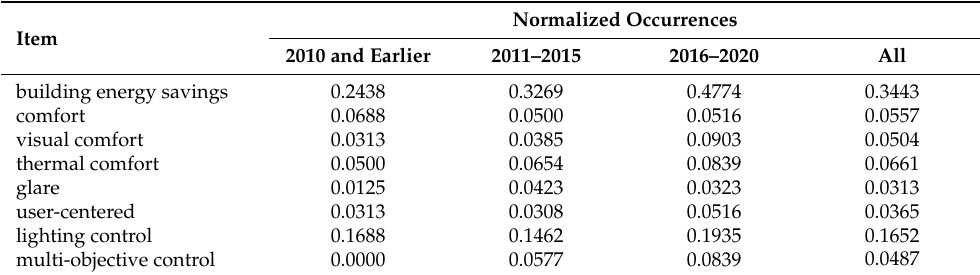
Table 5. Normalized occurrences of different target criteria of a building control as well as the normalized occurrences of the items lighting control and multi-objective control, determined by using